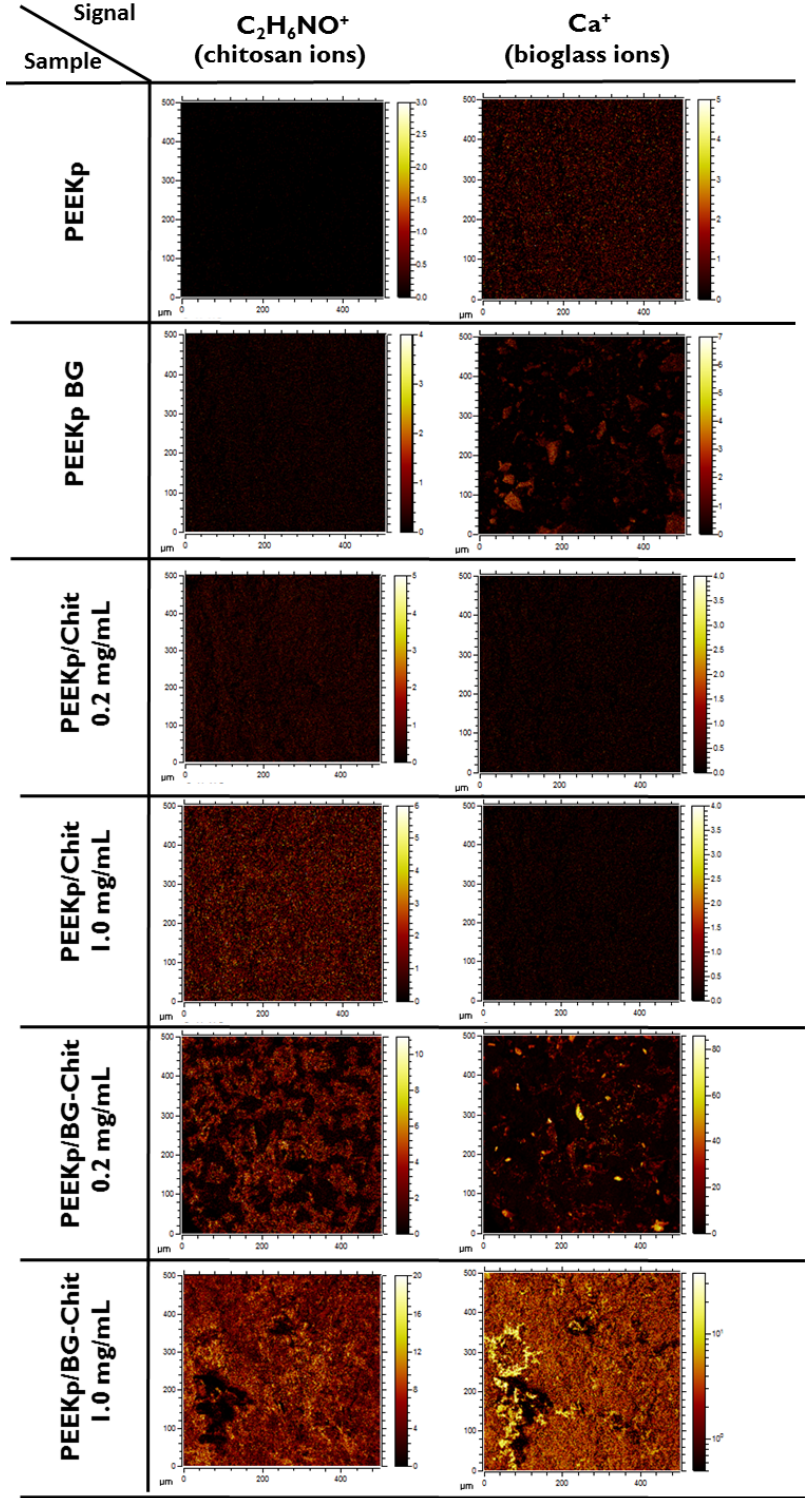
Figure 4. Lateral distribution of chitosan ( C 2 H 4 NO + ) and calcium ions ( Ca + ) obtained for the modified PEEK